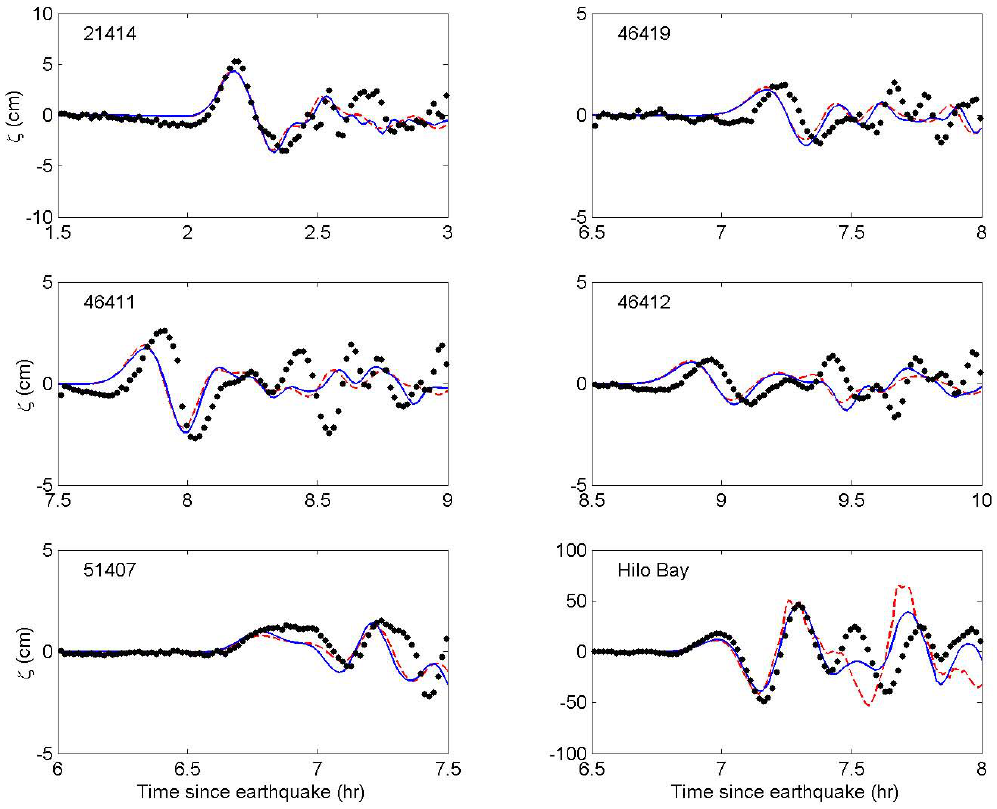
Fig. 17. Time series of water surface elevations at DART sensors and Hilo Bay tide station in the 2006 Kuril Islands tsunami event: Boussinesq (—), MOST (- -) and measurements ( (cid:5)